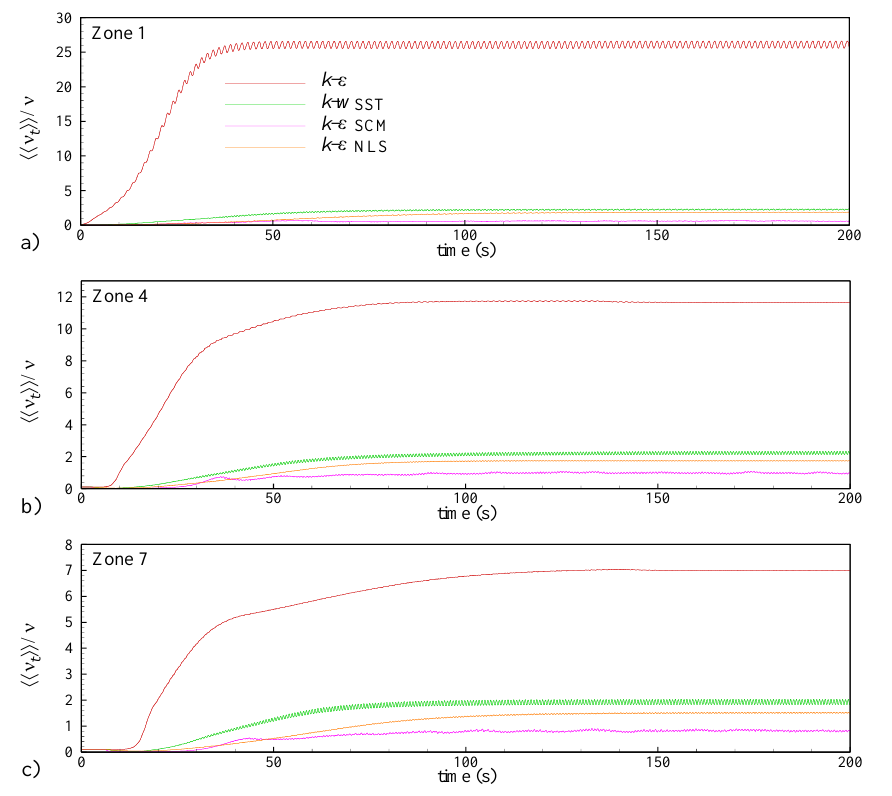
Figure 2. Time series of non-dimensional eddy viscosity (spatial average) in zone 1 ( a ), 4 ( b ), and 7 ( c ) for the wave propagation case for the four turbulence models.